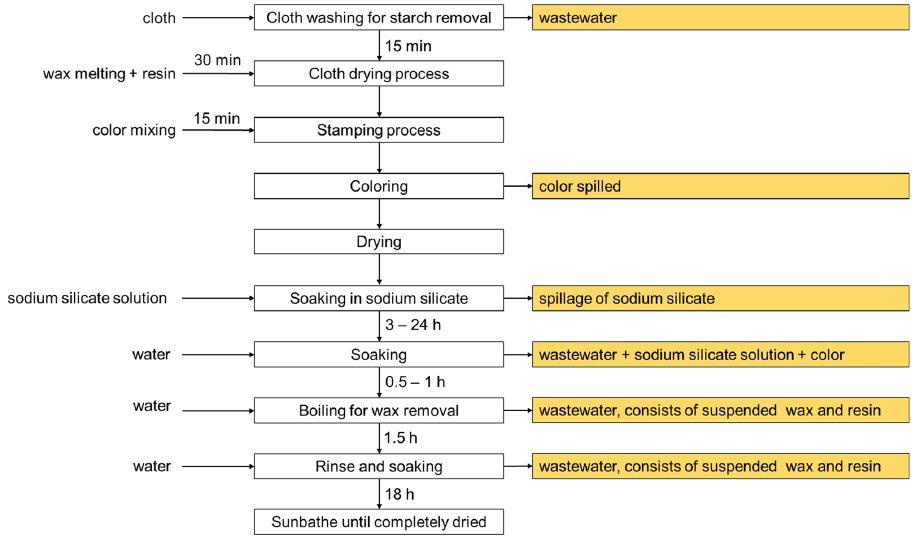
Figure 1. Flowchart of the batik process, where highlighted boxes show the possible sources for water pollution from batik making. This fl owchart was modi fi ed from [5].